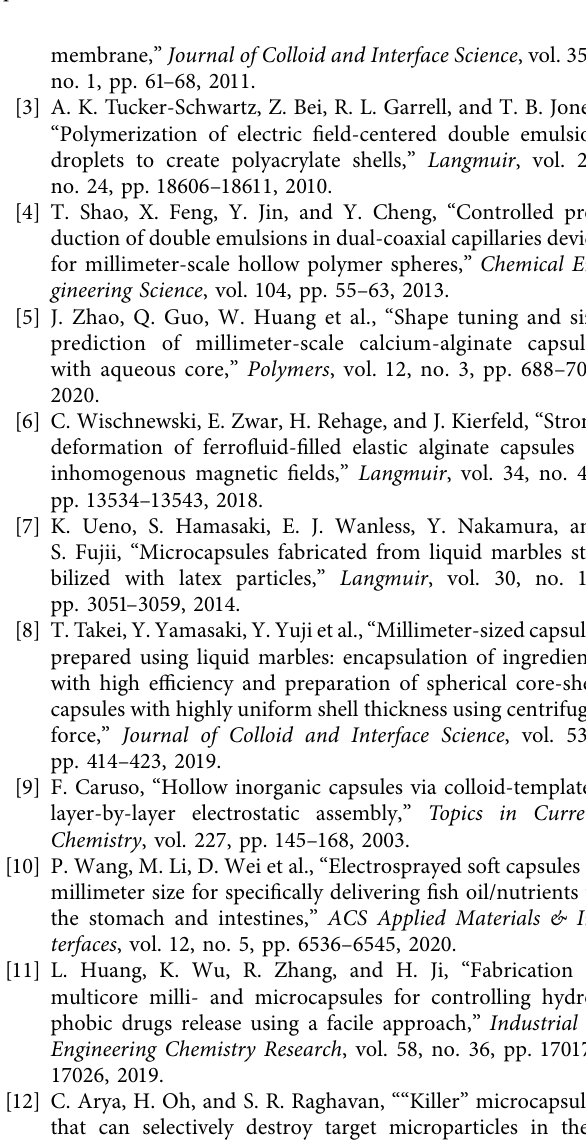
Figure 6: Effect of MWNTs concentration on water loss ratio of capsules at (a) test time 0–1920min and (b) test time